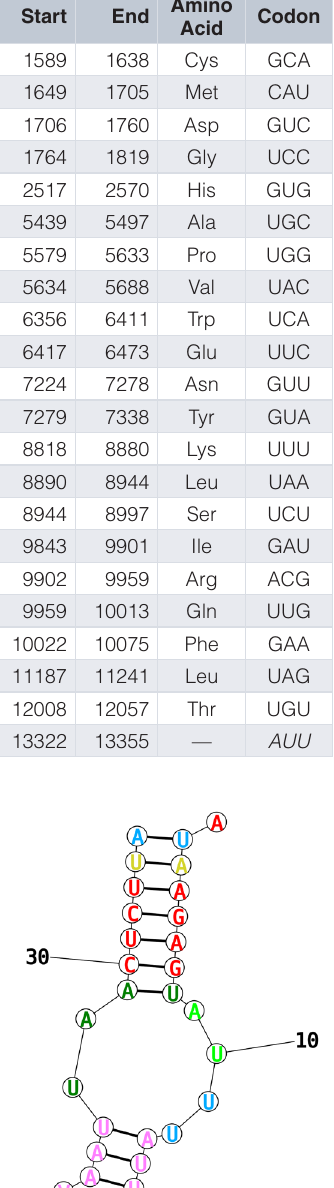
translation table 5: Invertebrate Mitochondrial) with NCBI SmartBLAST